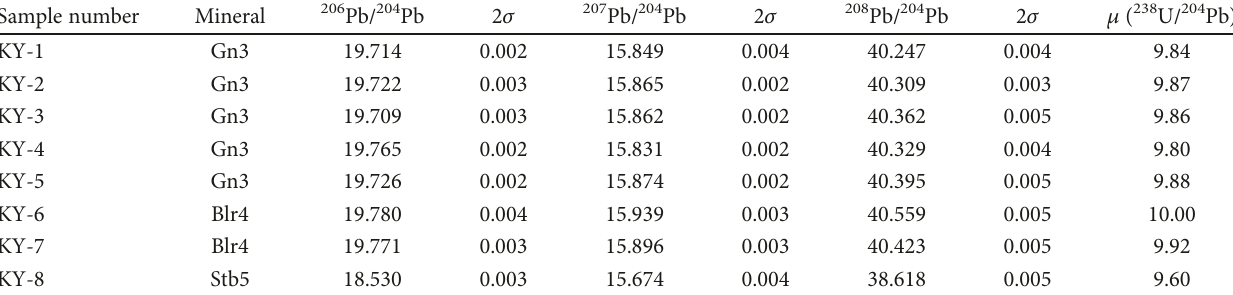
Table 5: The Pb isotopic data for sul fi des from the Keyue deposit. Sample